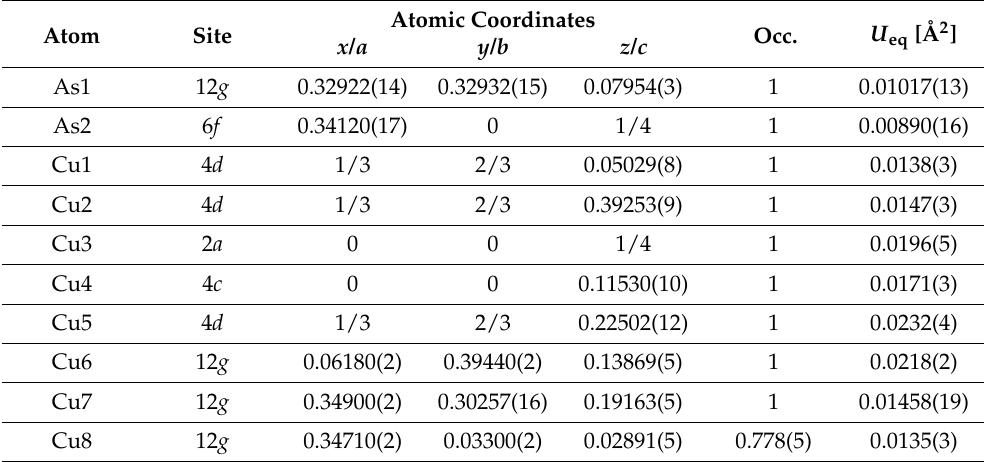
Table 7. Standardized atomic coordinates and equivalent displacement parameters (Ueq) for LT- Cu 2.825(5)